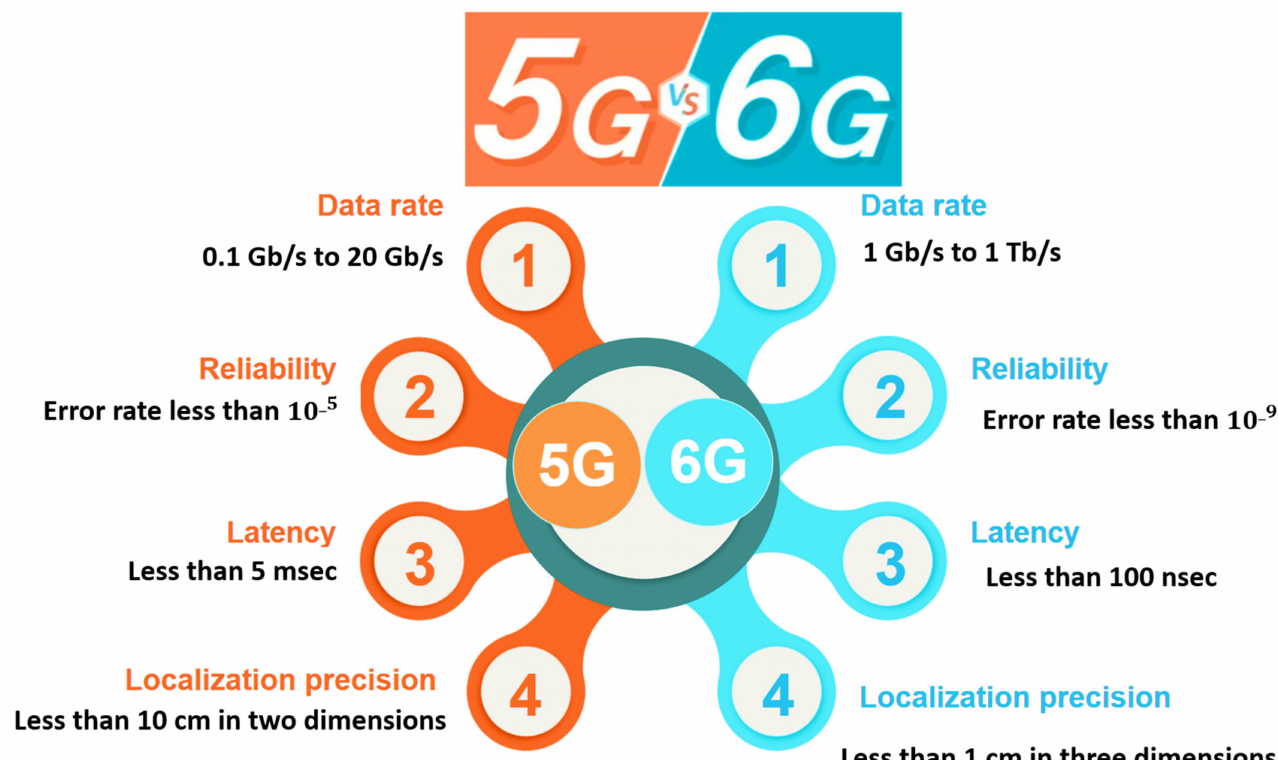
Figure 1. The 5G and 6G features